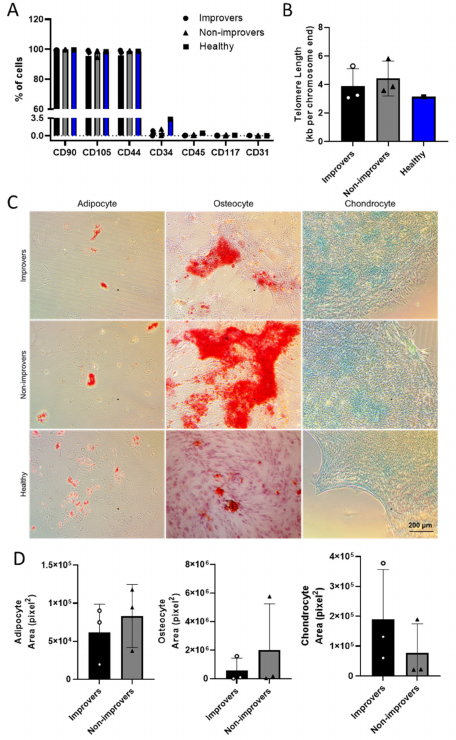
Figure 1. Characterization of MSCs derived from BMMNCs of improvers and non-improvers in passage 7 ( n = 3). ( A ) Expression of surface molecules by flow cytometry ( n = 3, improvers; n = 3, non-improvers; n = 1, healthy donor). ( B ) Telomere length of MSCs. ( C ) Representative images of differentiation capacity of MSC. Adipogenic differentiation showing lipid vacuoles in red (left). Osteogenic differentiation showing calcium deposits in red (middle). Chondrogenic differentiation showing glycosaminoglycans in blue (right). ( D ) Quantification of trilineage potential of MSC ( n =